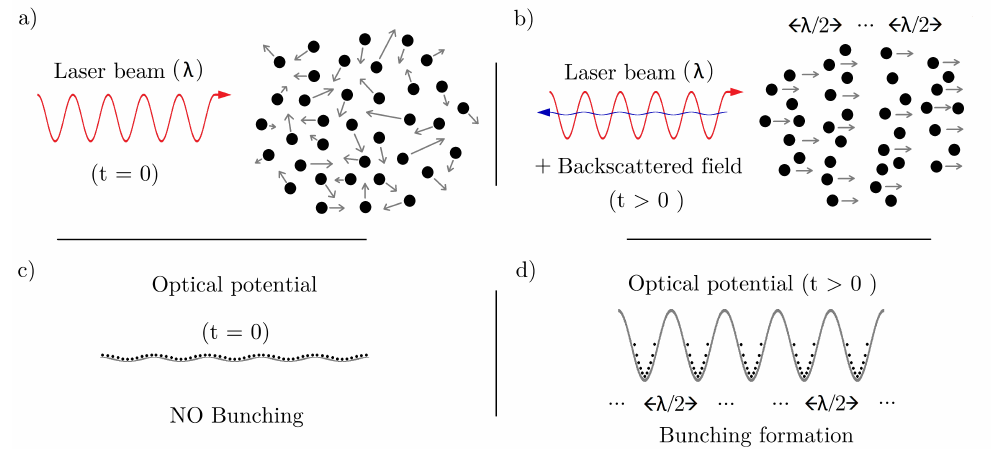
Figure 1. CARL schematics illustrating: redistribution of atoms from ( a ) the initial random distribu- tion to ( b ) spatially periodic density grating formation at time t > 0. The density grating formation occurs simultaneously with the appearance of a spatially periodic optical dipole potential which is ( c ) initially shallow, but becomes deeper ( d ) as a consequence of the interference between the laser beam and the amplified backscattered